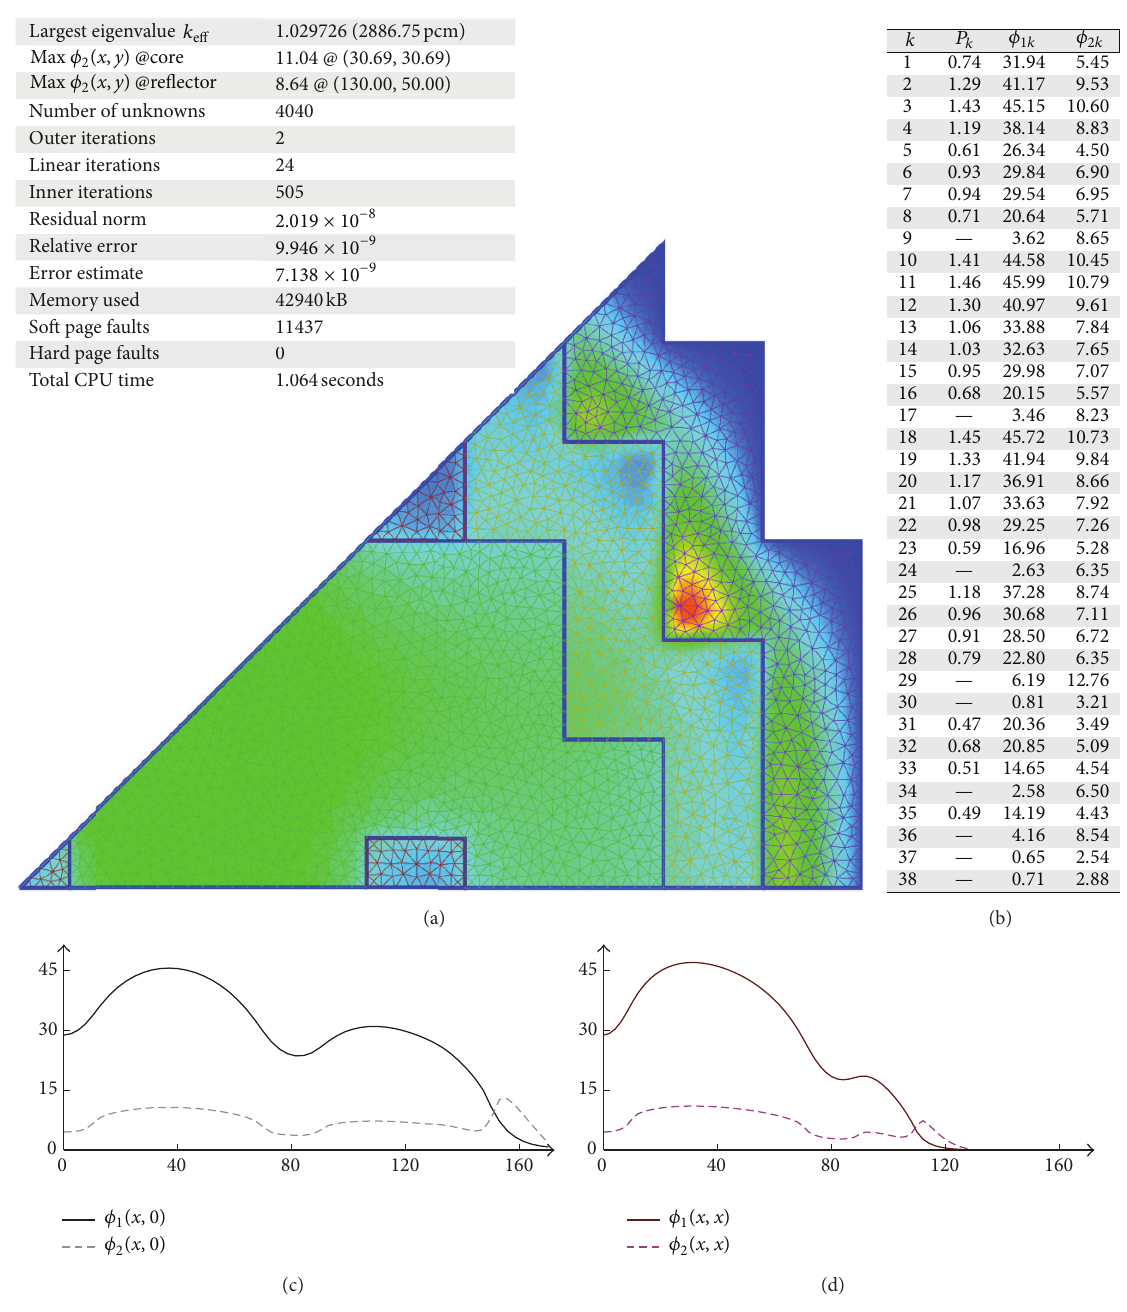
Figure 15: (a) Mesh and thermal flux distribution. (b) Power and fluxes. (c) Flux distribution 𝜙 𝑔 (𝑥,0) along the 𝑥 -axis. (d) Flux distribution (𝑥,𝑥) along the 𝜙 𝑔